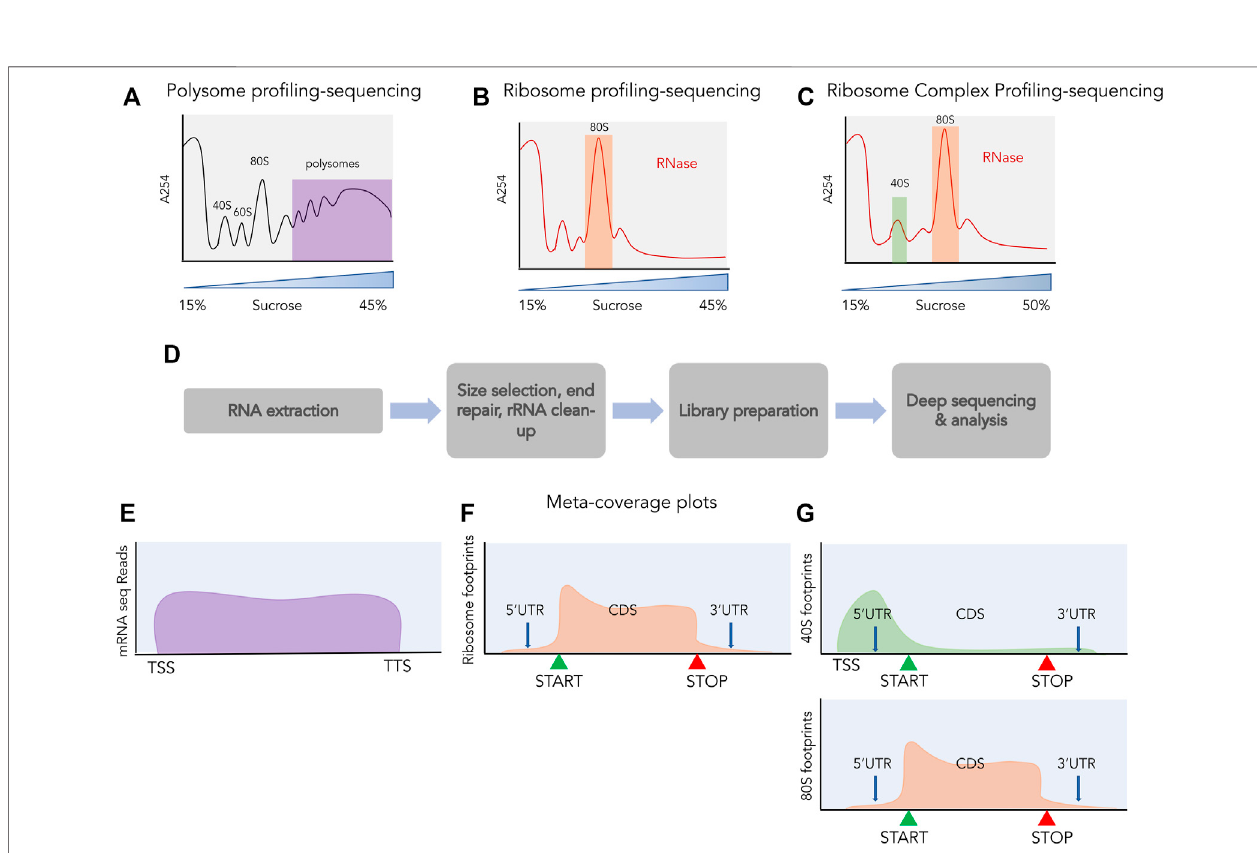
FIGURE 3 | Pro fi ling and sequencing of translating transcripts. A254 pro fi les shown before (A) and after digestion with ribonucleases (B,C) . The fractions used for further processing are highlighted, polysomes in purple, 80S in orange and 40S in green. (D) The process of library preparation for next generation sequencing. Size selection of ∼ 30 nt is done for ribosome pro fi ling and ribosome complex pro fi ling sequencing and libraries are prepared from the size selected small RNAs, whereas for polysome pro fi ling, libraries are prepared from total RNA. Meta-coverage shown for reads obtained from polysome pro fi ling sequencing (E) , for ribosome pro fi ling (F) and for ribosome complex pro fi ling [ (G) top: 40S, bottom: 80S].